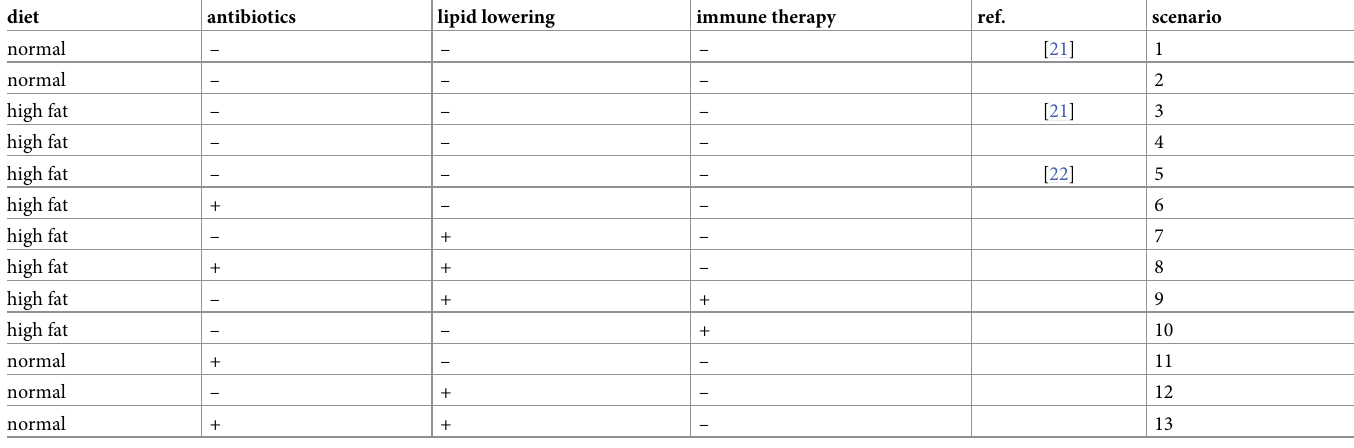
Table 2. Experimental groups. Groups differ with respect to diet (high fat diet vs. normal diet), antibiotic treatment (broad-spectrum antibiotics vs. none), immune mod- ulation (IL-10 blockage or not) and lipid lowering agent (short-chain fatty acid propionate vs. none). Data of scenarios 1, 3 and 5 were retrieved from the literature. diet